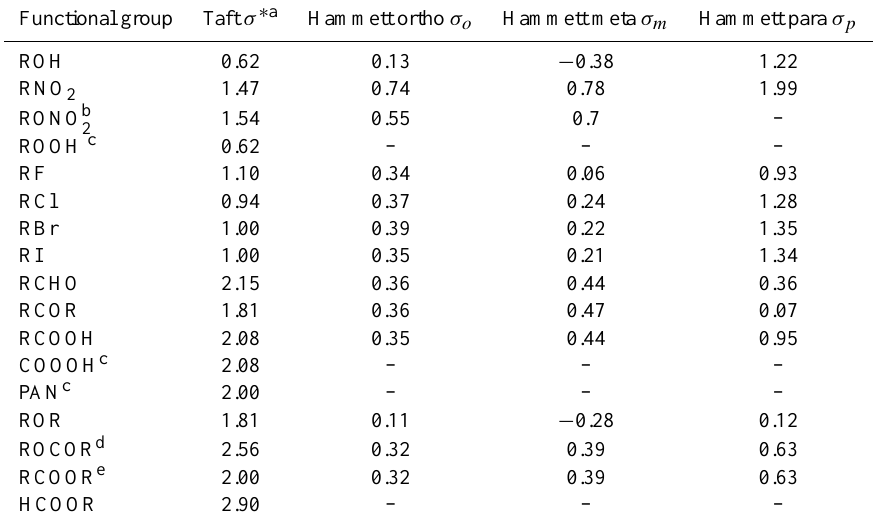
Table 2. Sigma Taft and Hammett values for organic functional groups (adapted from Perrin et al., 1981). Functional group